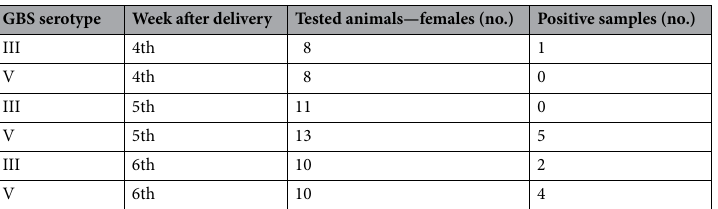
GBS serotype Week after delivery Tested animals—females (no.) Positive samples